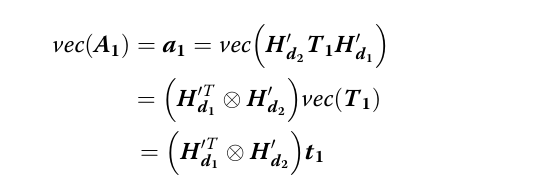
controllable/adjustable complex-valued